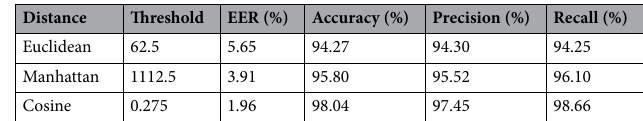
Table 4. Comparison of Euclidean, Manhattan and cosine distances.